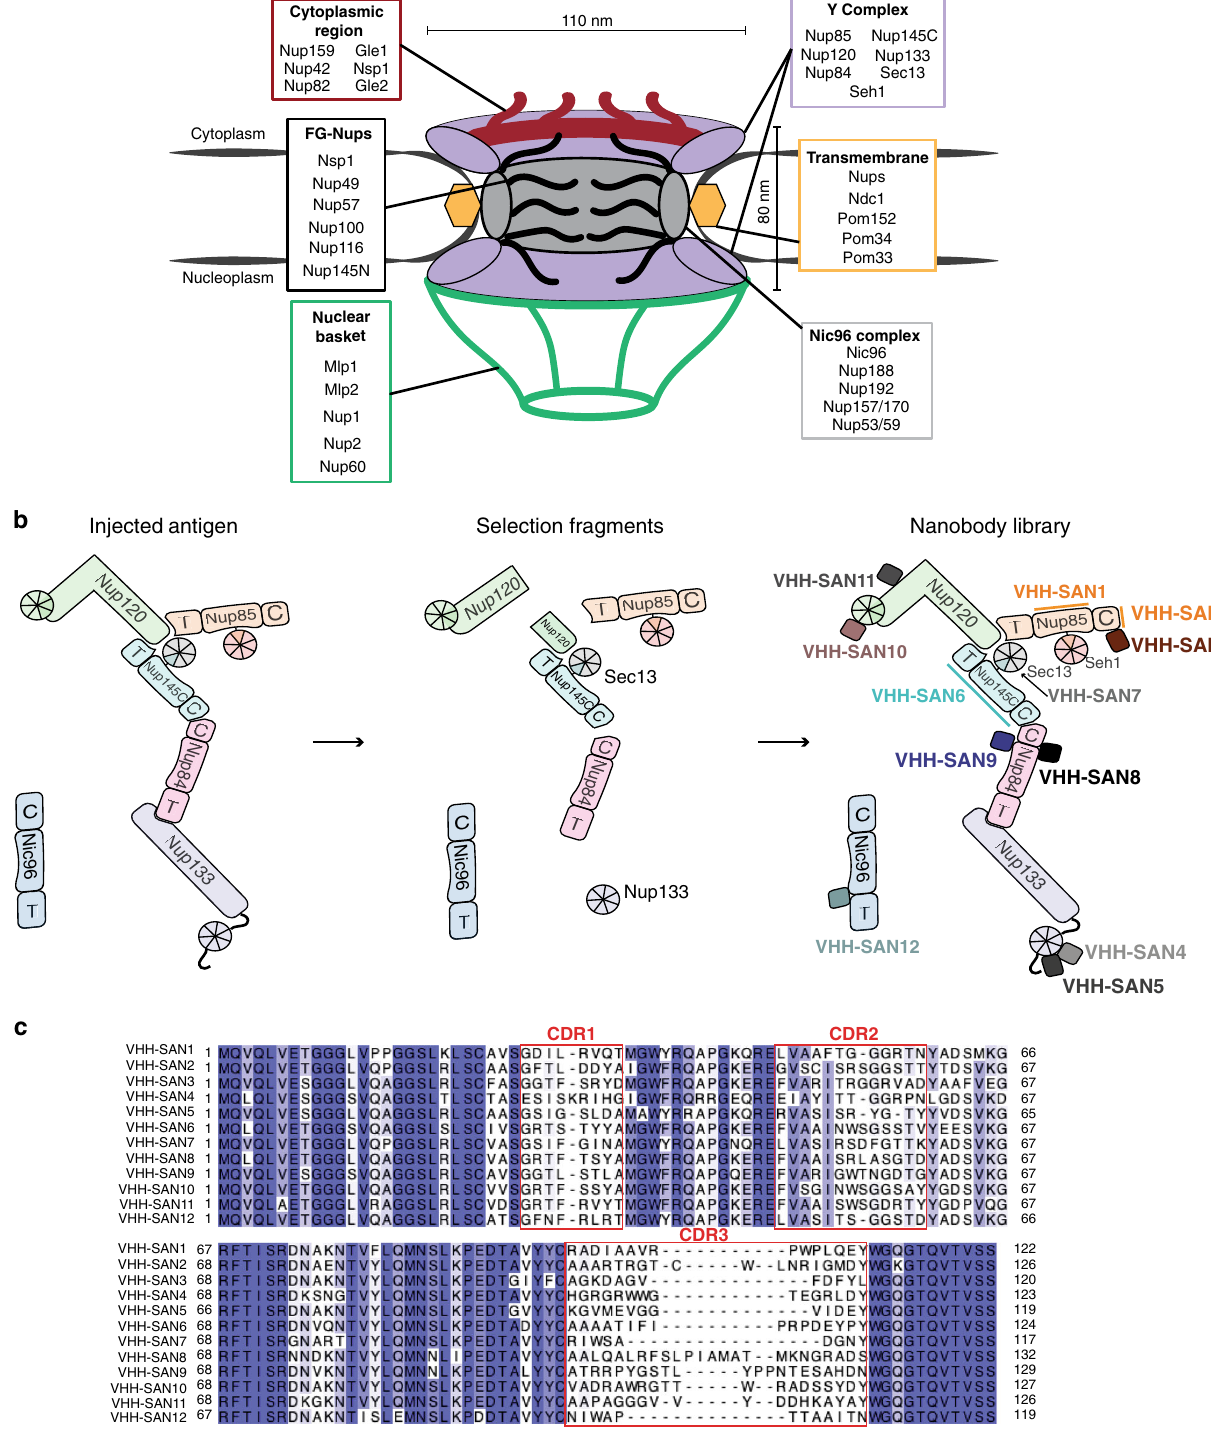
Fig. 1 A nanobody library to scaffold nucleoporins. a Schematic of the NPC assembly and classi fi cation of yeast nups. Each subcomplex or type of nup is listed together in a box and the relative position within the NPC assembly is indicated. b Schematic of the Y complex and Nic96 used for alpaca immunization, selection by phage display, and resulting nanobody library. Elements of ACE1 fold proteins are indicated: T — tail and C — crown adjacent to the central trunk element. c Sequence alignment of the nanobody library, colored by percentage identity. Variable complementarity determining regions (CDRs) are